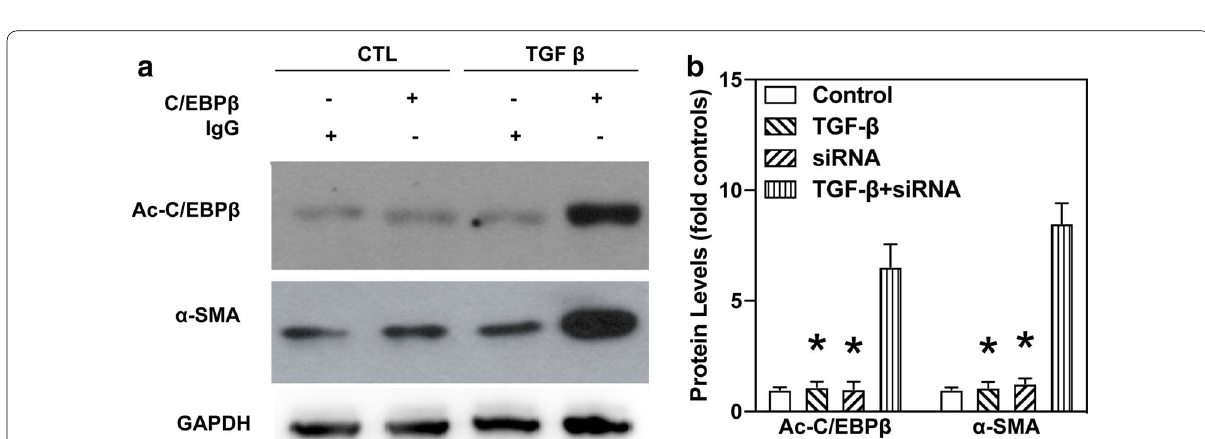
Fig. 5 Involvement of C/EBPβ acetylation in TGF-β-induced EMT in A549 cells. a Cell lysates were prepared from A549 cells treated with 10 ng/mL TGF-β for 24 h. After treatment with the C/EBPβ antibody (described in “Methods”), C/EBPβ acetylation was shown to be involved in TGF-β-induced α-SMA expression. b Quantification of western blots were calculated according to grey analysis. However, elevated expression of acetylated C/EBPβ and α-SMA proteins was not observed in A549 cells treated with IgG during immunoprecipitation. Data show mean significant difference (P < 0.05) compared to the